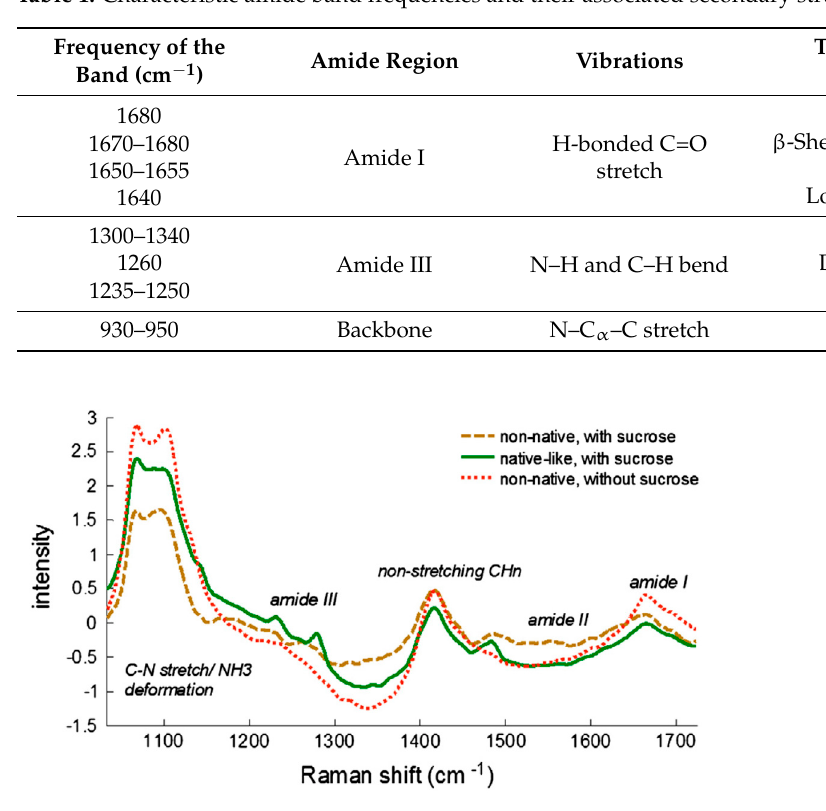
Figure 6. Raman spectra of native-like and denatured (non-native) freeze-dried LDH. Sample concentration 9 mg/mL, 6.5 mg of material used. Reproduced with permission from [24], Elsevier, 2013.